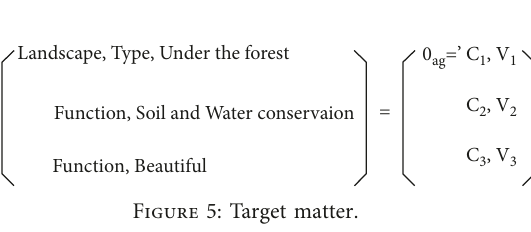
Figure 5: Target